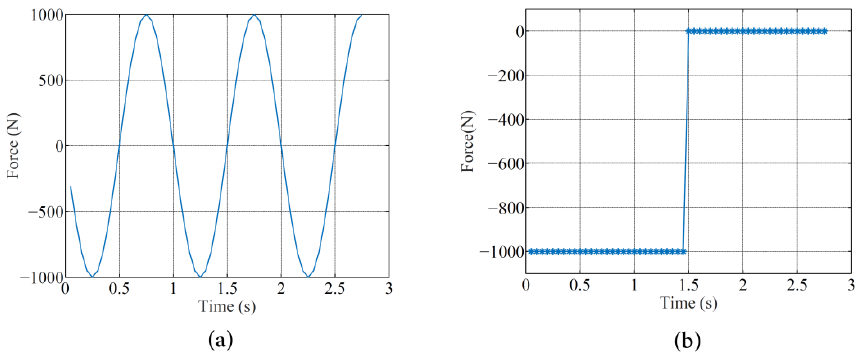
Figure 5. Actual time variation in the moving load: ( a ) sinusoidal; and ( b ) step function.